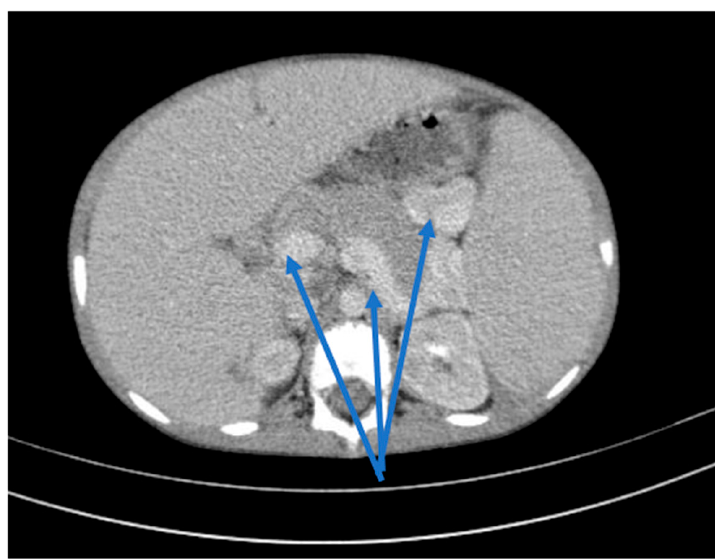
Figure 3. Axial CT scans, bilateral medullary nephrocalcinosis (blue arrow).